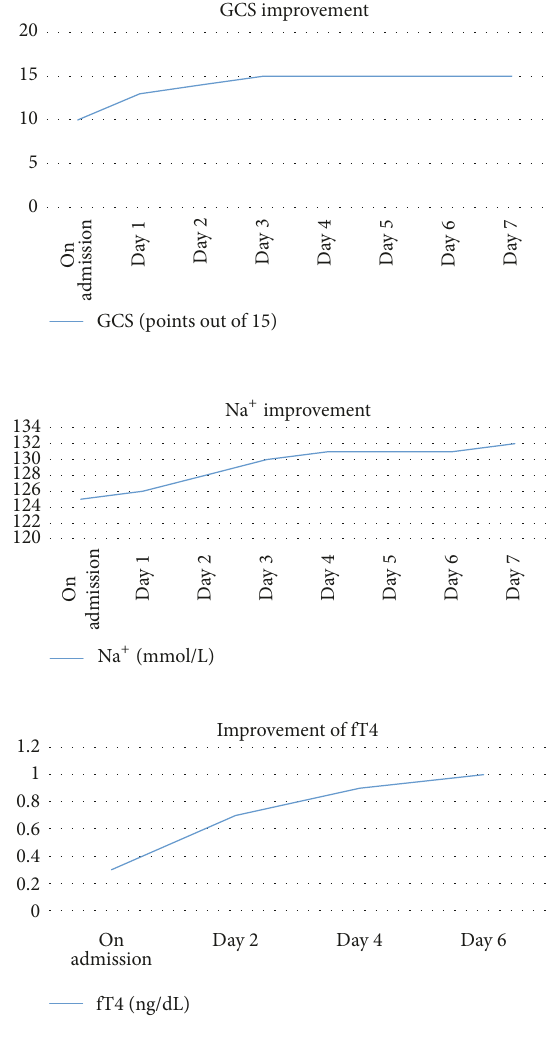
Figure 1: Improvement of parameters following